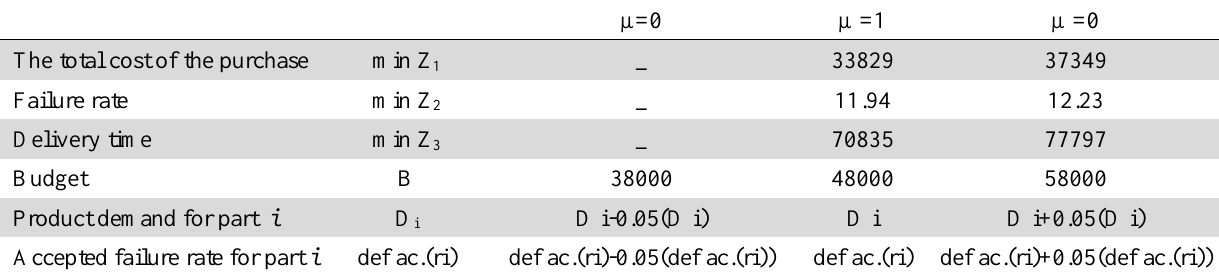
The summary of some input